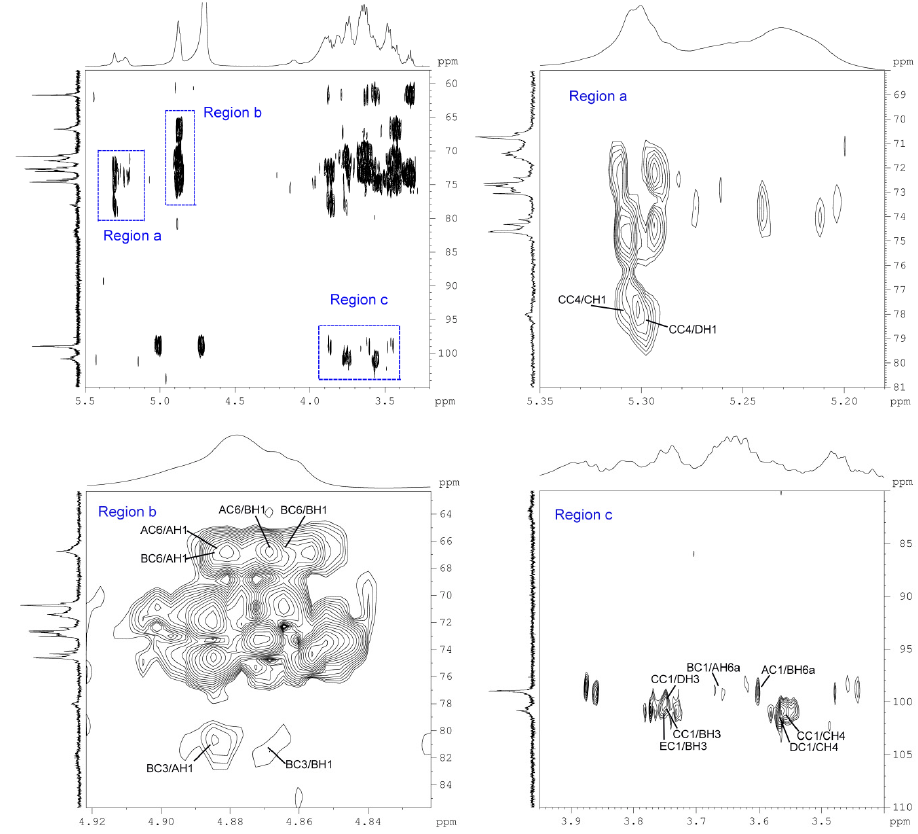
Figure 3. HMBC spectra of BP1: The inter-residue 1 H- 13 C long-range correlations used for linkage and sequence assignments are listed in Table 3. Table 3. The significant 3 J H,C correlations observed in the HMBC spectrum of BP1.